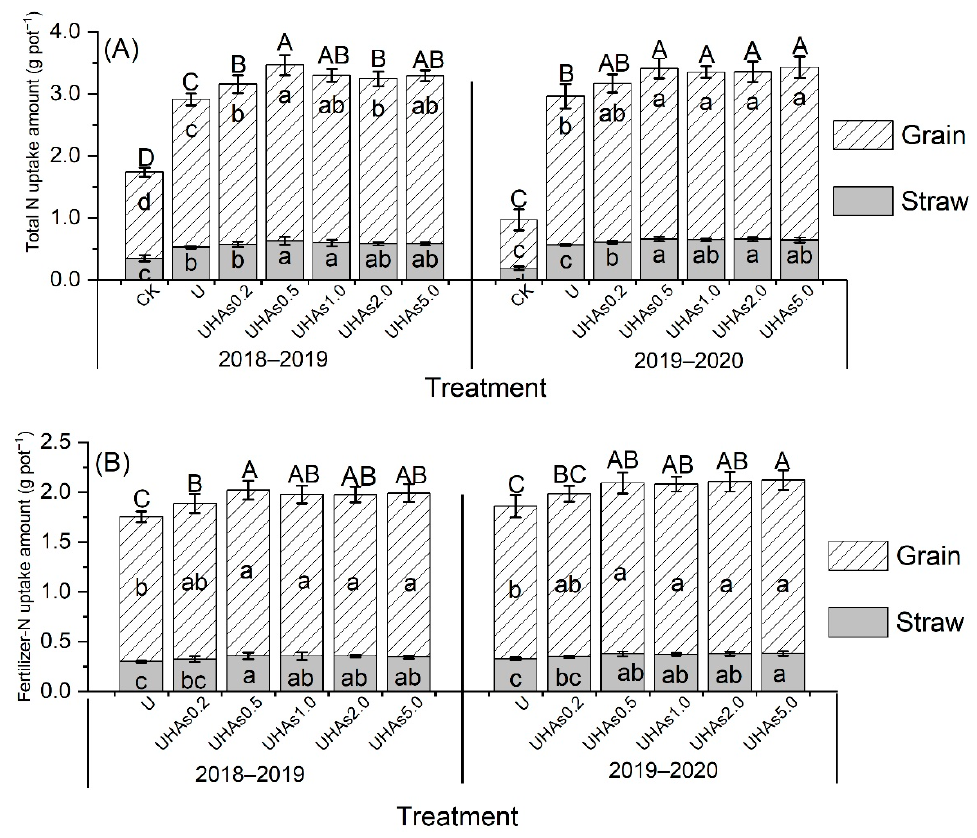
Figure 4. N accumulation in mature winter wheat under different proportions of HAs in urea fertilizer formulations. ( A ) Total N; ( B ) Fertilizer-N. Treatments with no letter in common were significantly different at p < 0.05, as indicated by LSD test. The capital letter above columns resulted from the differences of total aboveground parts of mature winter wheat among treatments.